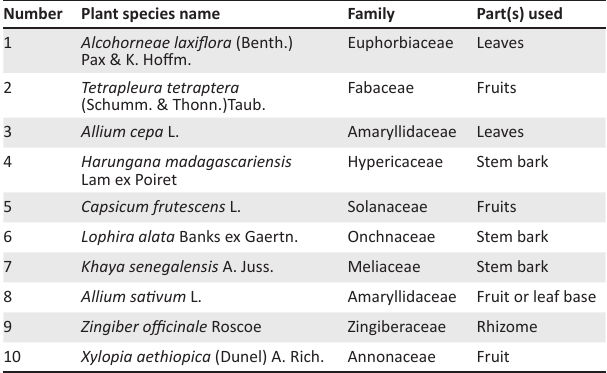
TABLE 10: Names of plants and their parts used for the formulation of traditional oral powdered herbal formulations for the treatment of high blood pressure in Ogbomoso, Nigeria.